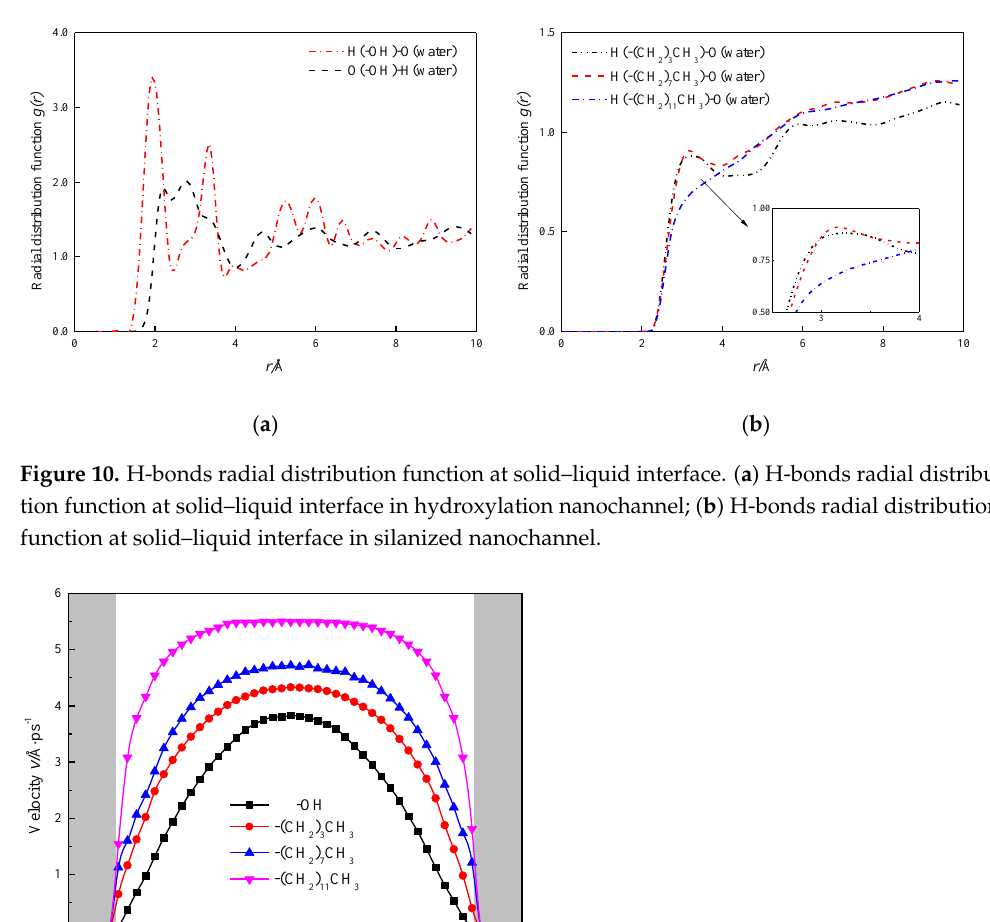
Figure 10. H-bonds radial distribution function at solid–liquid interface. ( a ) H-bonds radial distri- bution function at solid–liquid interface in hydroxylation nanochannel; ( b ) H-bonds radial distri- bution function at solid–liquid interface in silanized nanochannel.